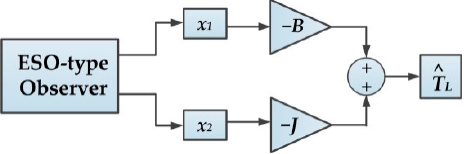
Figure 14. Block diagram of the estimation of the load torque T L .